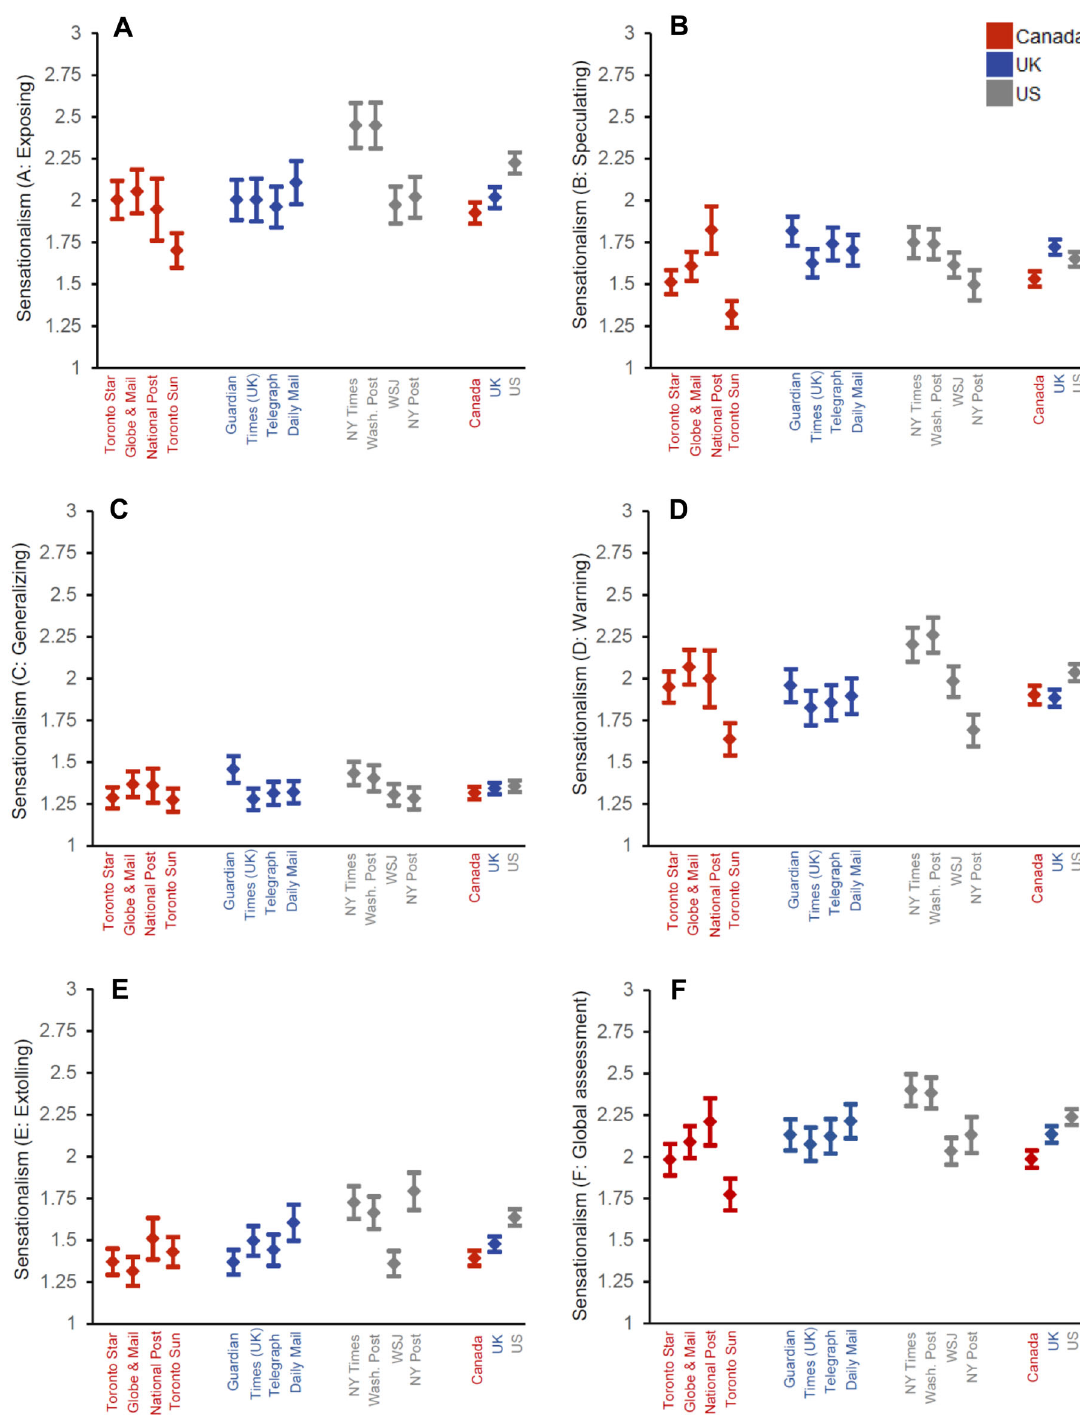
Fig. 4 Sensationalism of news media articles by news outlet and country of publication. Scores for six sensationalism questions (SI Coding Tool) are shown (mean, 95% con fi dence interval) for articles ( n = 1331) communicating COVID-19 public health or policy information (Fig. 2): ( A ) exposing, ( B ) speculating, ( C ) generalizing, ( D ) warning, ( E ) extolling, and ( F ) global assessment (i.e., an overall assessment of the degree of sensationalism in the article). Each question was evaluated on a scale from 1 to 5 (5 corresponding to highest sensationalism). Sampled articles were published between 1